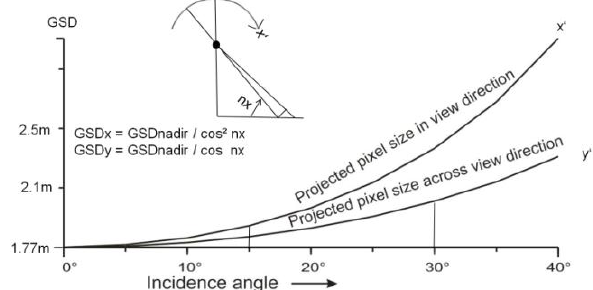
Figure 1. Ground sampling distance as function of nadir angle The original thin layer film of CORONA images with a usable size of approximately 75cm x 5.5cm is available scanned with 7µm pixel size in 4 overlapping parts. The pixel size leads from a flying elevation of 254km with the focal length of 610mm to the nominal GSD of 1.77m in the centre and 2.18m x 2.69m at the film ends (figure 1). An analysis of the image